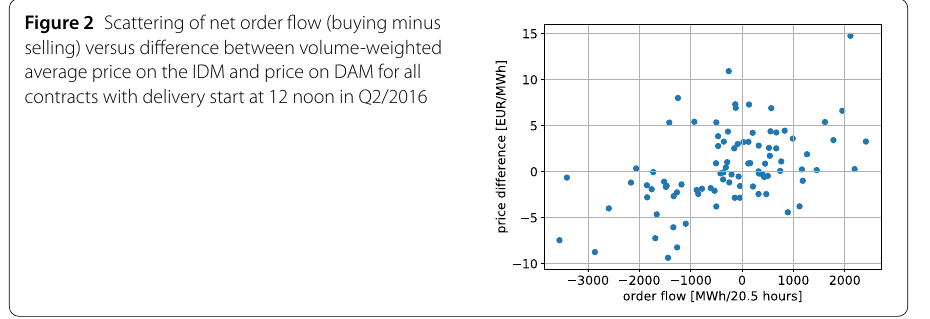
Figure 2 Scattering of net order flow (buying minus selling) versus difference between volume-weighted average price on the IDM and price on DAM for all contracts with delivery start at 12 noon in